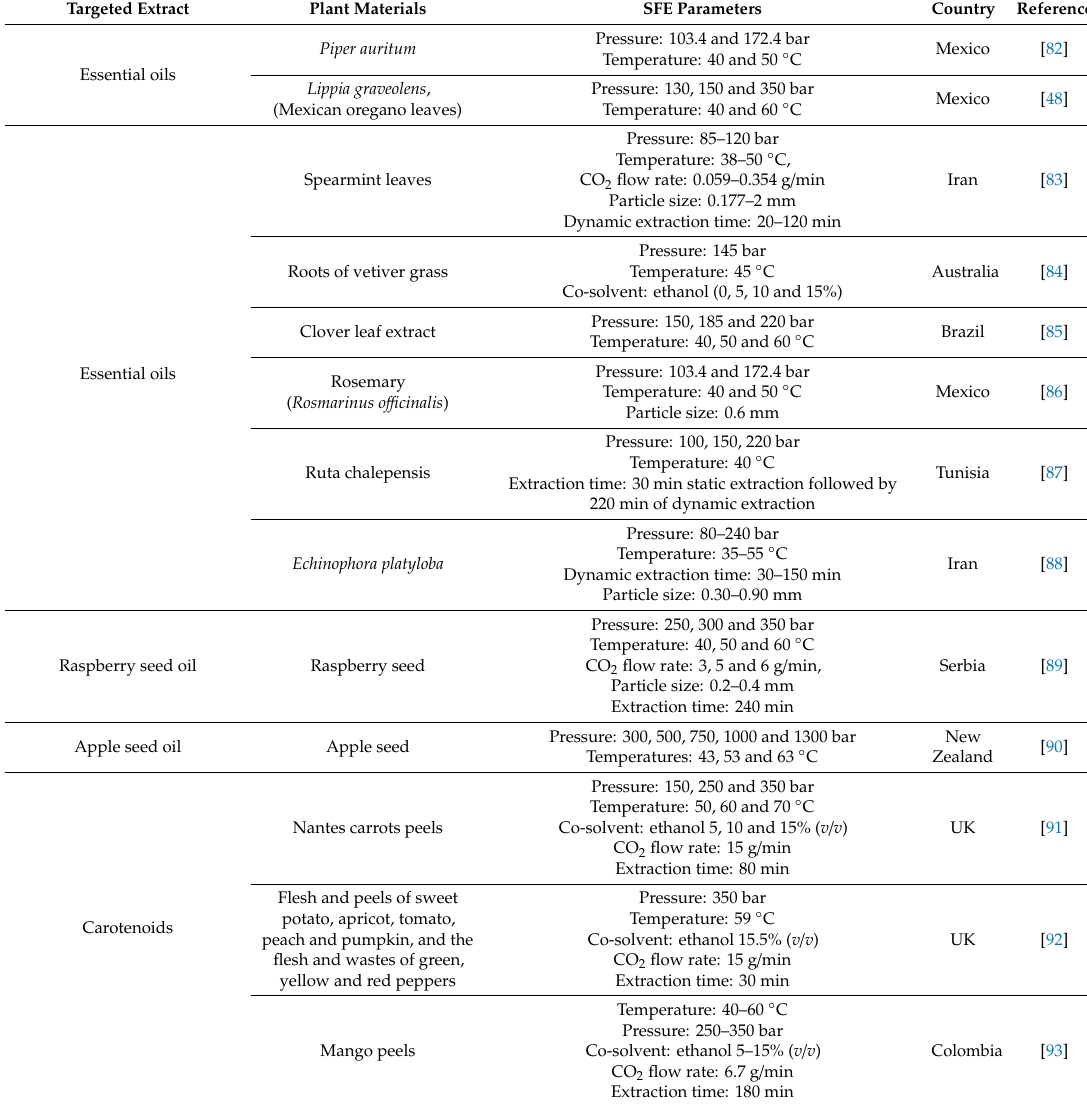
Table 5. Examples of terpenoids extracted by supercritical CO 2